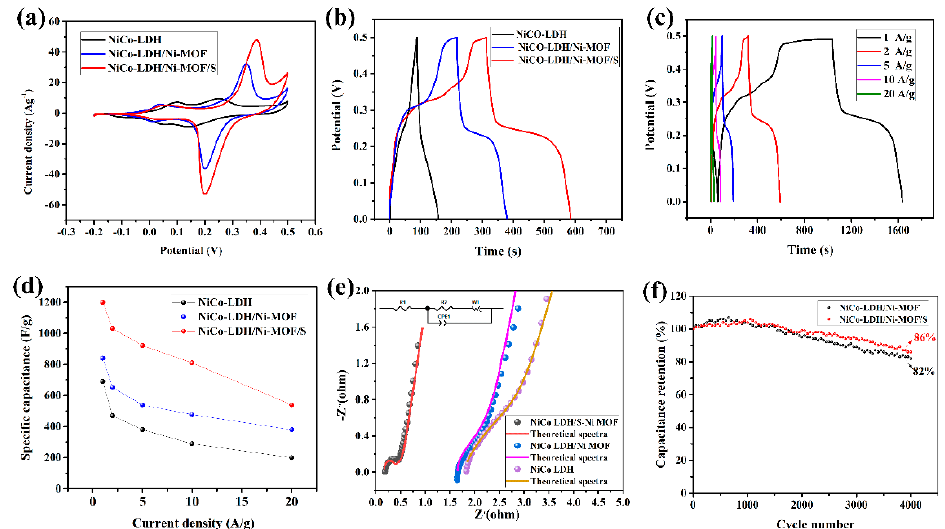
Figure 5. ( a ) comparison of CV curves of NiCo LDH, NiCo LDH/Ni MOF, and NiCo LDH/S-Ni MOF at 2 mV s − 1 ; ( b ) Galvanostatic discharge curves of NiCo LDH, NiCo LDH/Ni MOF, and NiCo LDH/S-Ni MOF sample at a current density of 2 A g − 1 ; ( c ) corresponding GCD curves of NiCo LDH/S-Ni MOF at different current density; ( d ) capacitance of NiCo LDH, NiCo LDH/S-Ni MOF, and NiCo LDH/S-Ni MOF electrodes at different current density; ( e ) Nyquist plots of Ni-Co LDH, NiCo LDH/Ni MOF and NiCo LDH/S-Ni MOF; ( f ) cycling stability comparison of NiCo LDH/Ni MOF electrodes and NiCo LDH/S-Ni MOF electrodes at the current density of 5 A g − 1 .